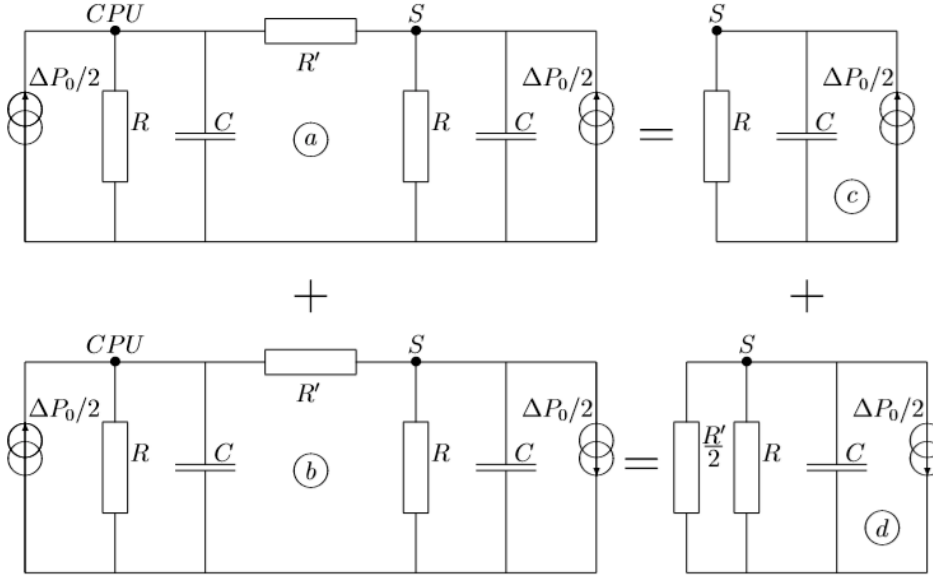
Figure A1. Equivalent thermal network represented as the superposition of a symmetrical and an antisymmetrical network.